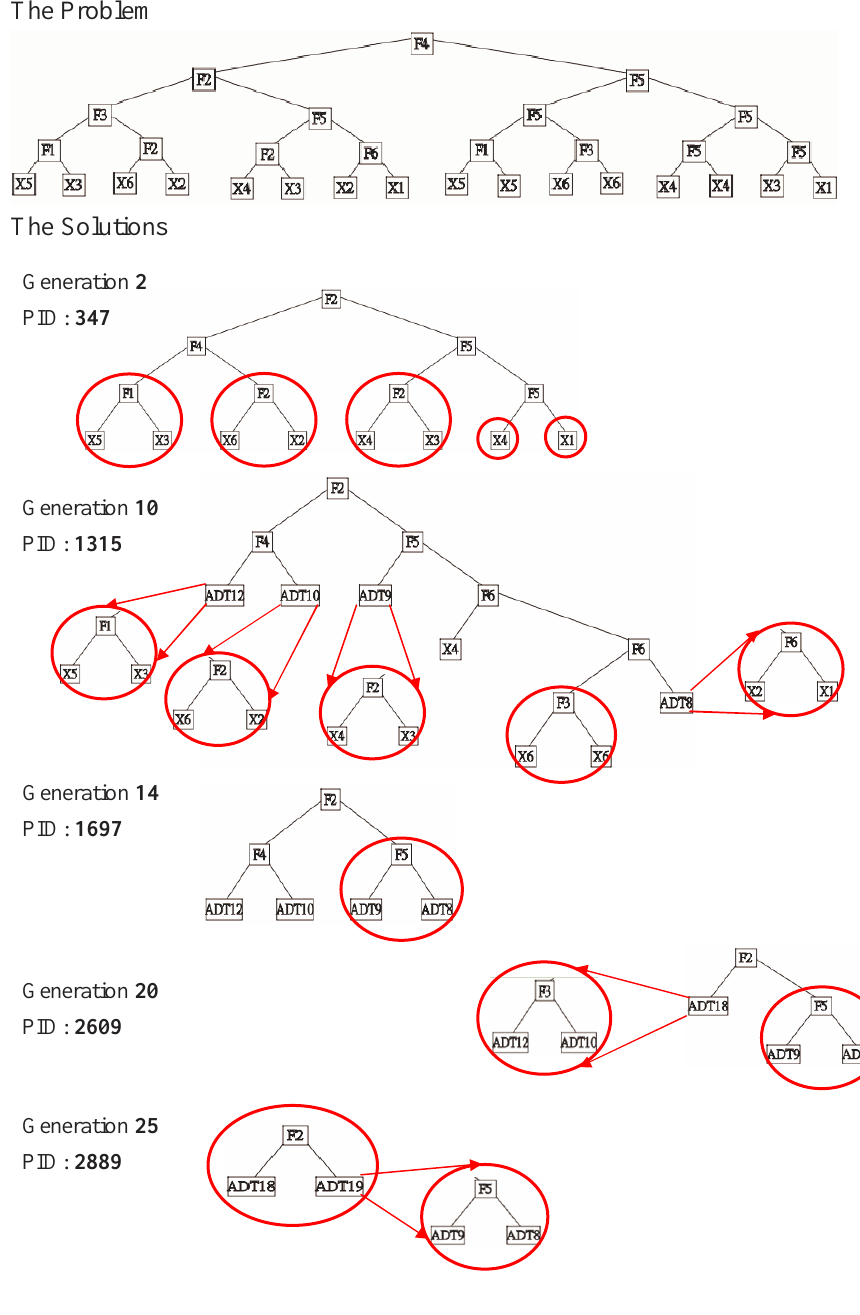
Figure 6. Hierarchical representation of the evolution of an artificial